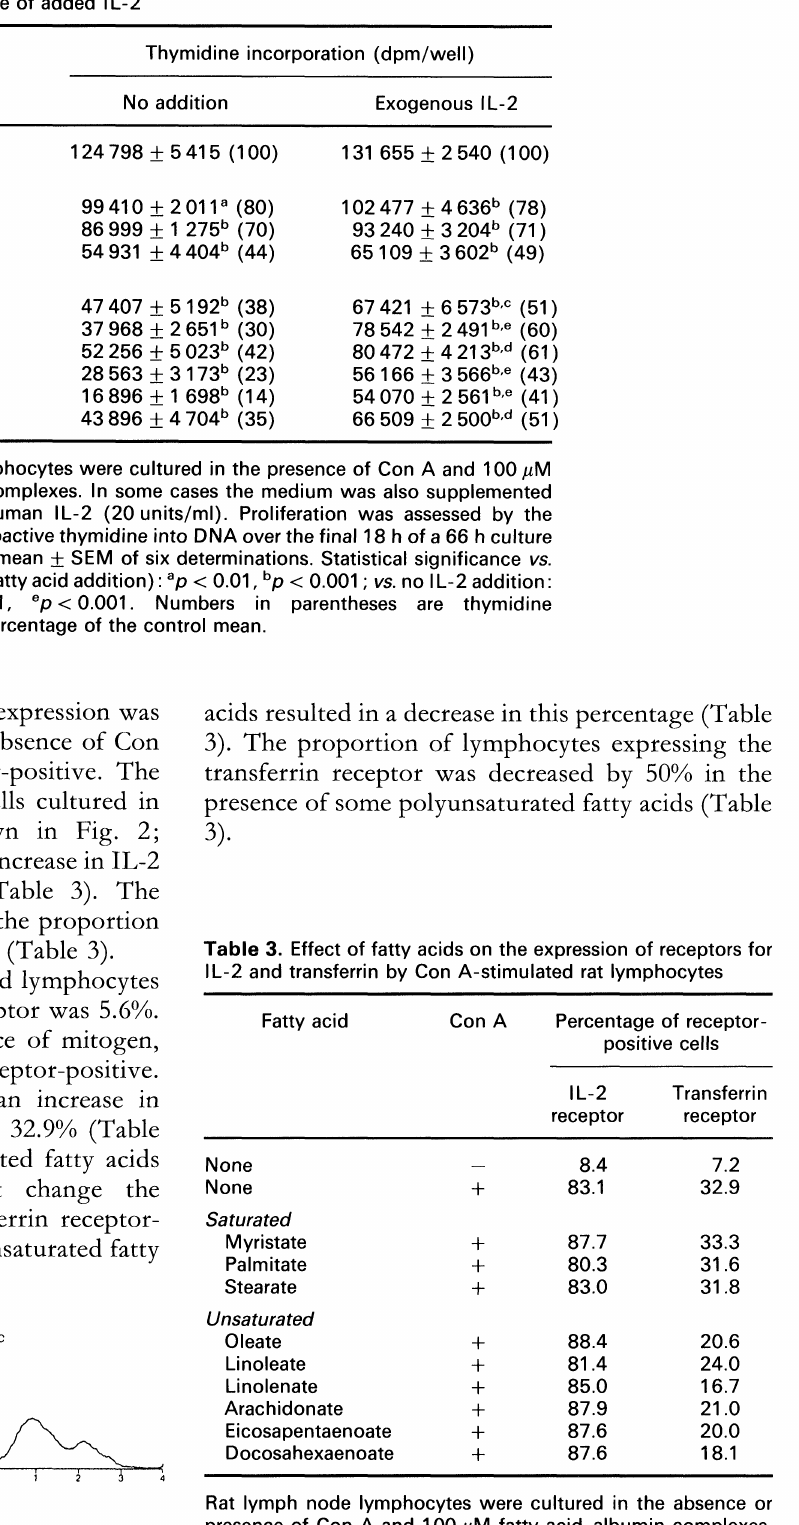
FIG. 2. Immunofluorescent profiles of Con A-stimulated lymphocytes. Rat lymph node lymphocytes were cultured in the presence of Con A. After 48 h the cells were washed and prepared for FACS analysis as described in Materials and Methods. The cells were incubated with (a) MRC OX-21 (anti-human C3b activator protein), (b) MRC OX-39 (anti-lL-2 receptor) or (c) MRC OX-26 (anti-transferrin receptor) and then stained with RAM-FITC. Stained cells were analysed in a FACScan analyser and the percentage of positive cells was determined by standard computerized methods.